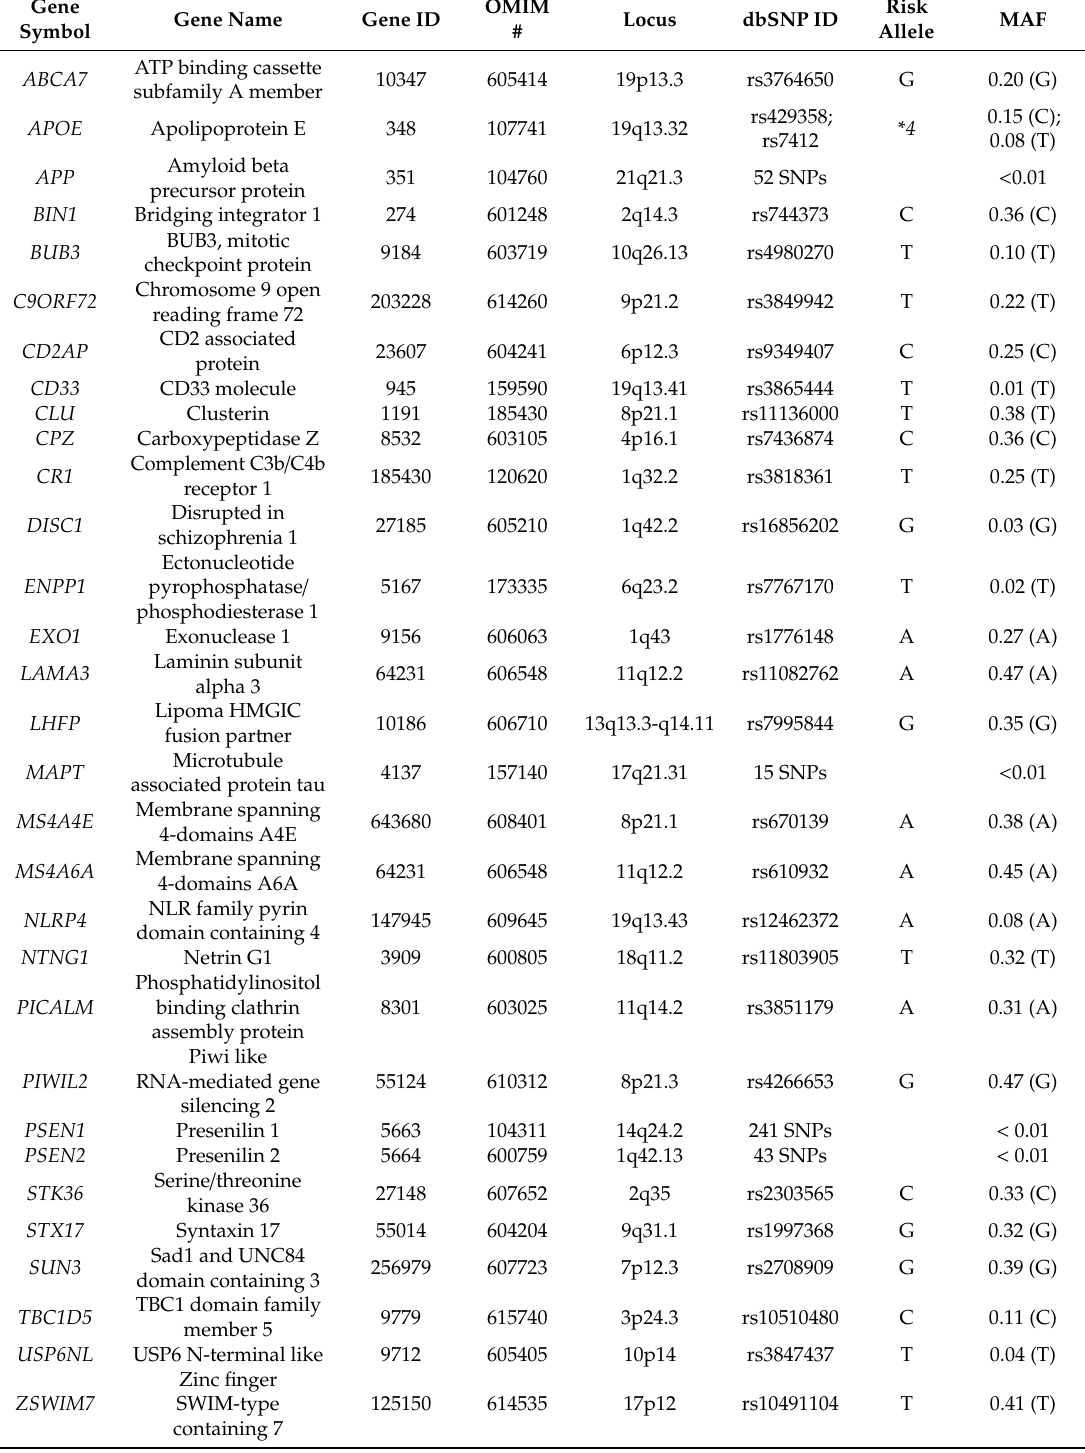
Table 1. Prevalent Alzheimer’s disease-related pathogenic